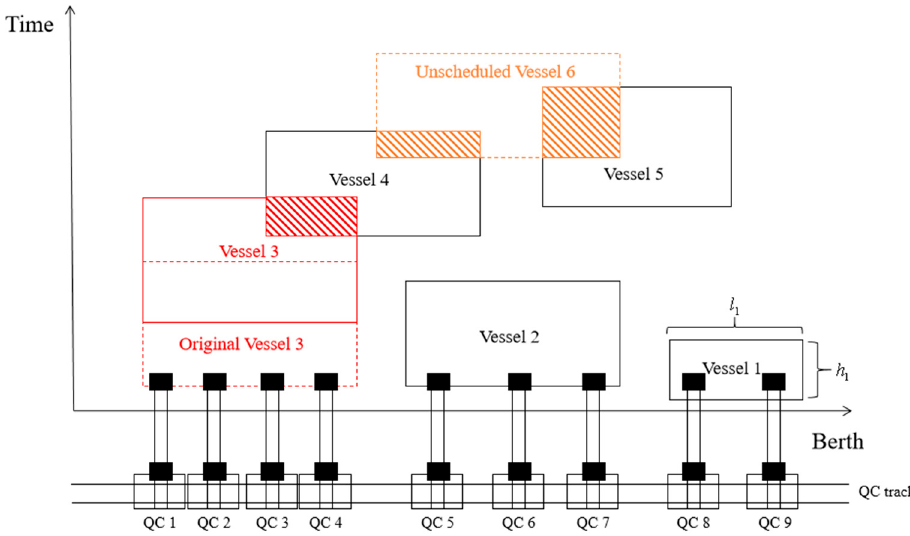
Figure 1. Uncertainty scenario diagram.